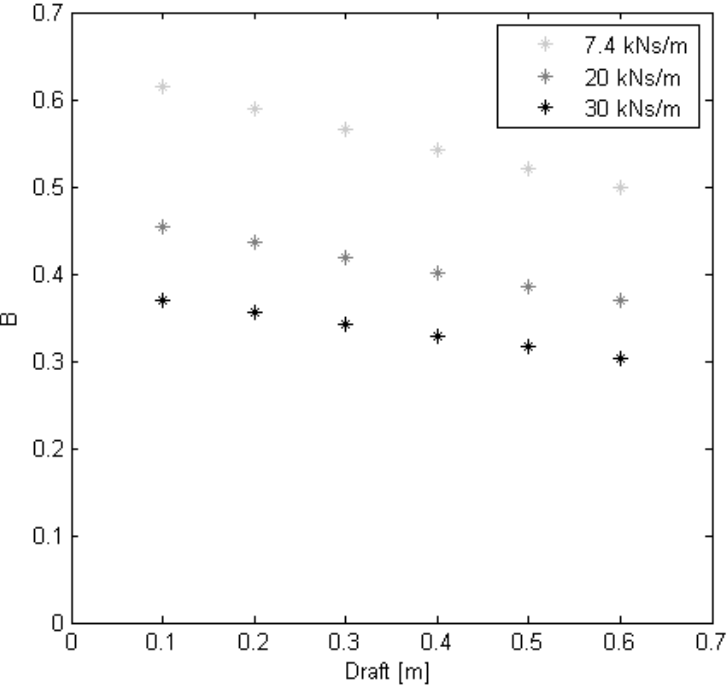
Figure 6. Velocity ratio B as a function of buoy draft. The radius was simulated as constant, a = 2 m, while the draft was varied. The mass was simulated as constant, m = 2000